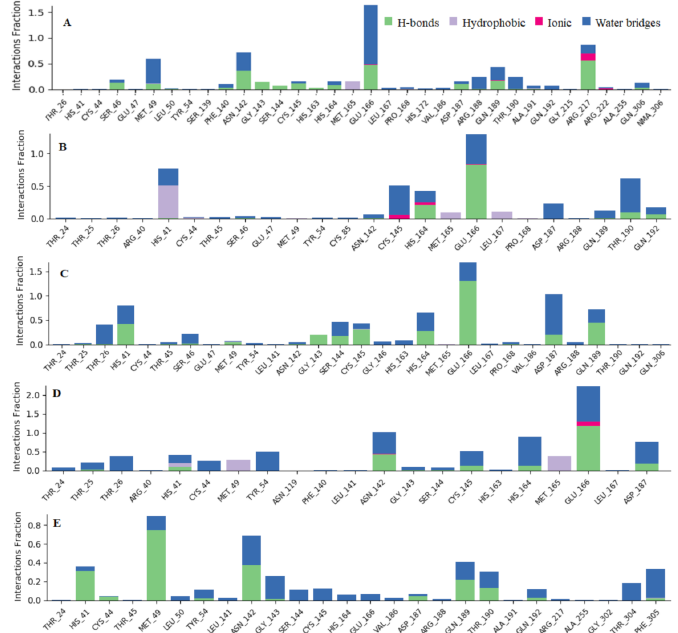
Figure 6. Observed M pro -ligands interaction during the 100 ns MD simulation. Interactions include; hydrogen bonds, hydrophobic, ionic and water bridges. Letter codes indicate: Quercetin-3-O- Neohesperidoside ( A ), Quercetin 3-Rhamnoside ( B ), Myricitrin ( C ), Rutin ( D ), and Myricetin 3- Rutinoside ( E